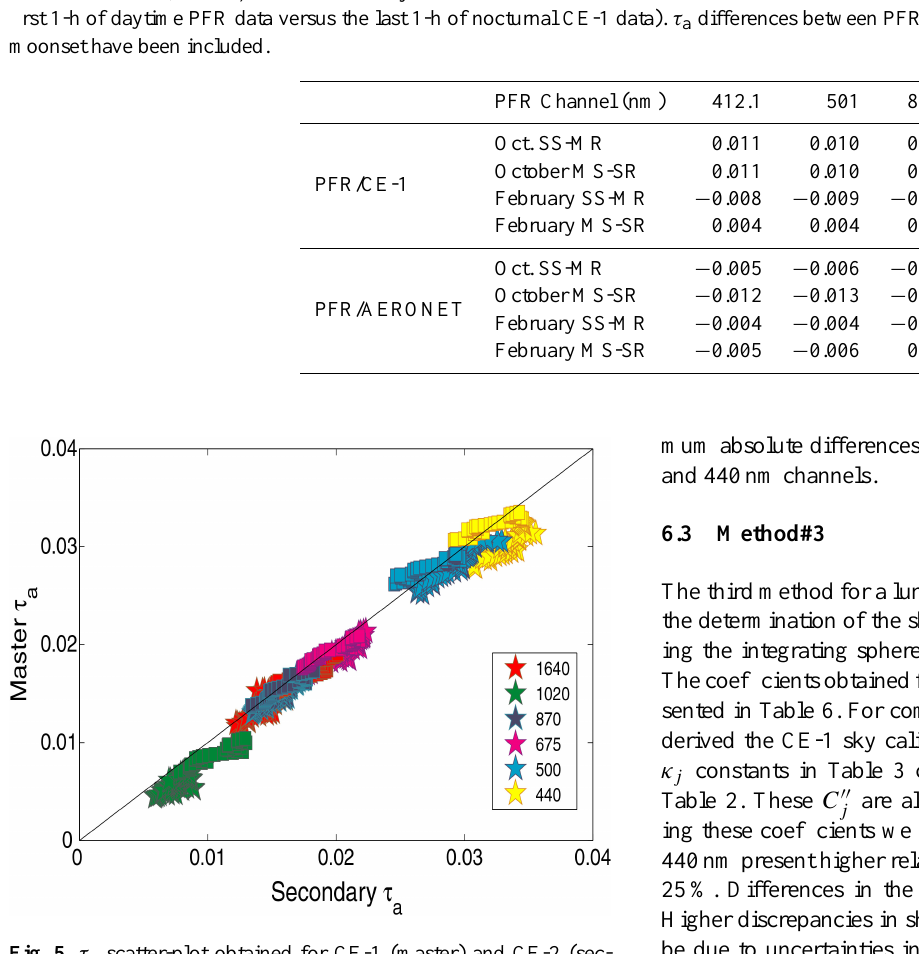
Fig. 5. τ a scatter-plot obtained for CE-1 (master) and CE-2 (secondary) using calibration Method # 2 for 9 February (stars) and 10 February (squares), 2012.